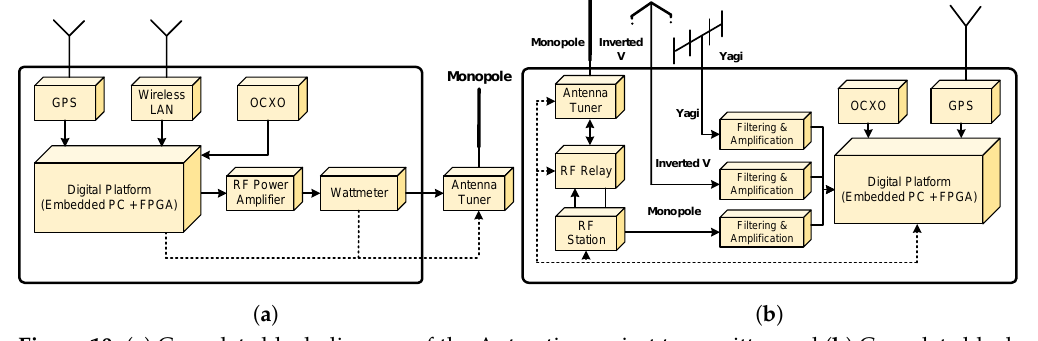
Figure 10. ( a ) Complete block diagram of the Antarctica project transmitter and ( b ) Complete block diagram of the Antarctica project